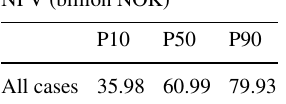
Fig. 10 NPV’s cumulative density function. All uncertainty cases Table 4 NPV’s probabilities